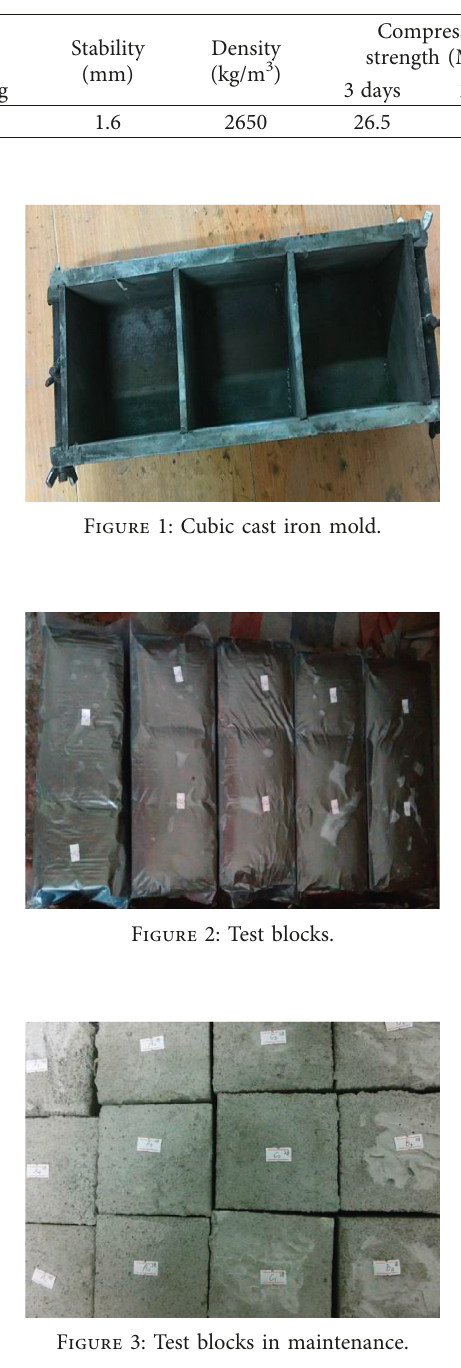
Table 1: Test items and results of cement.